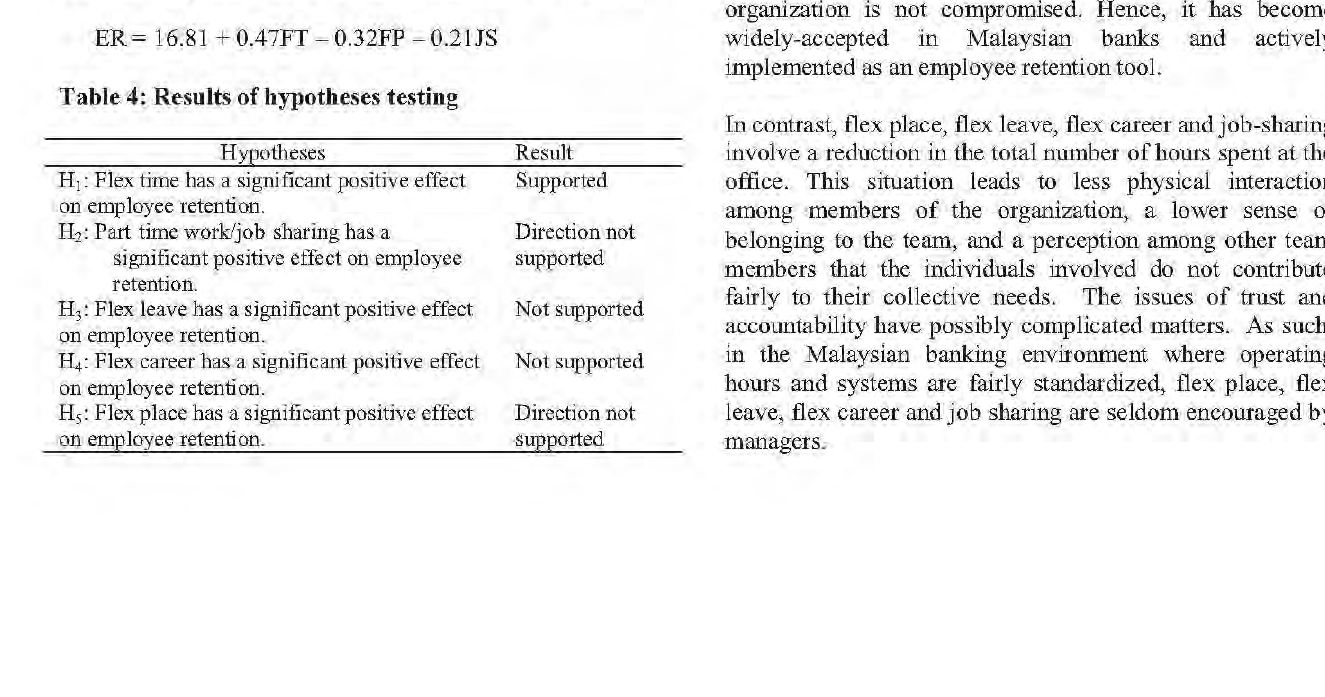
Table 4: Results of hypotheses testing